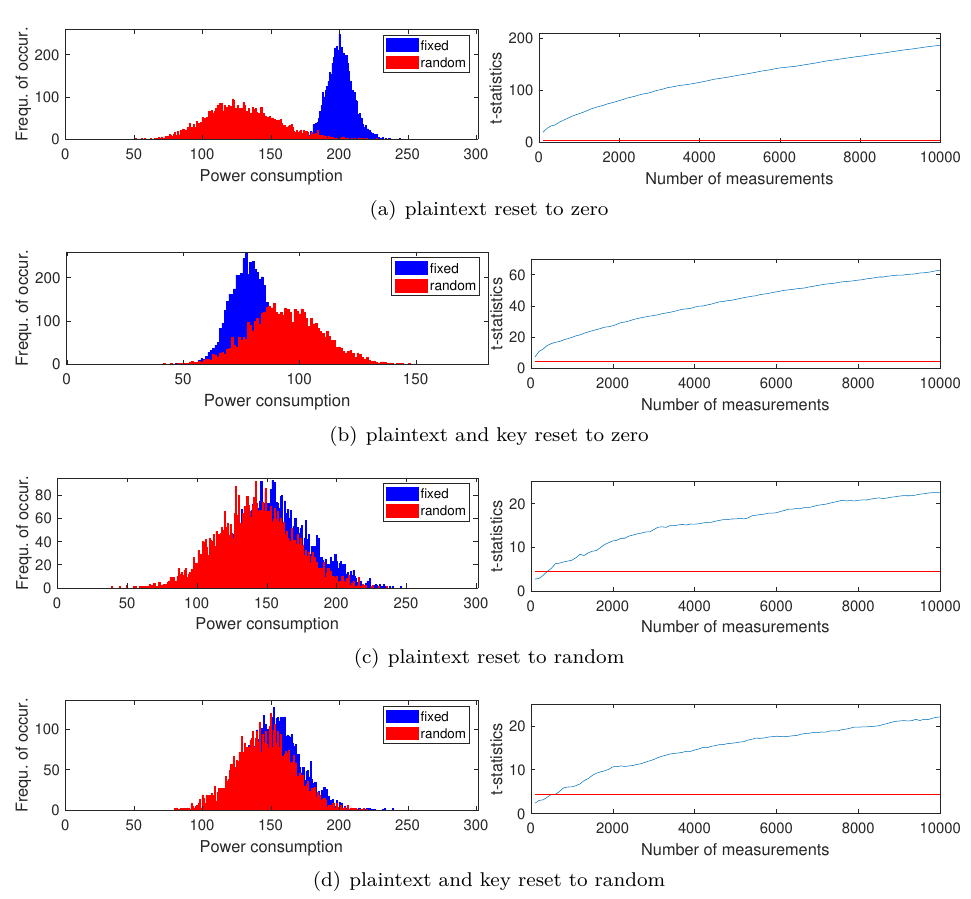
Figure 8: Histograms of the fixed and random groups at the most leaking time sample and development of the maximum t -value over the number of traces for 4 different reset